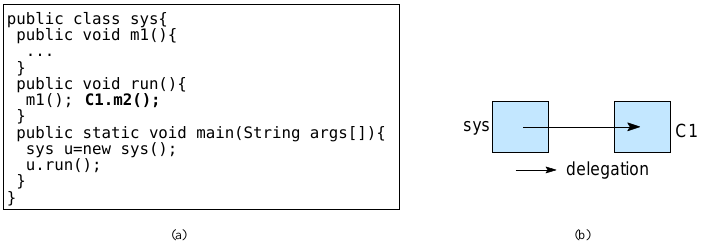
Figure 8. Object delegation in: ( a ) Code and ( b ) Block diagram.